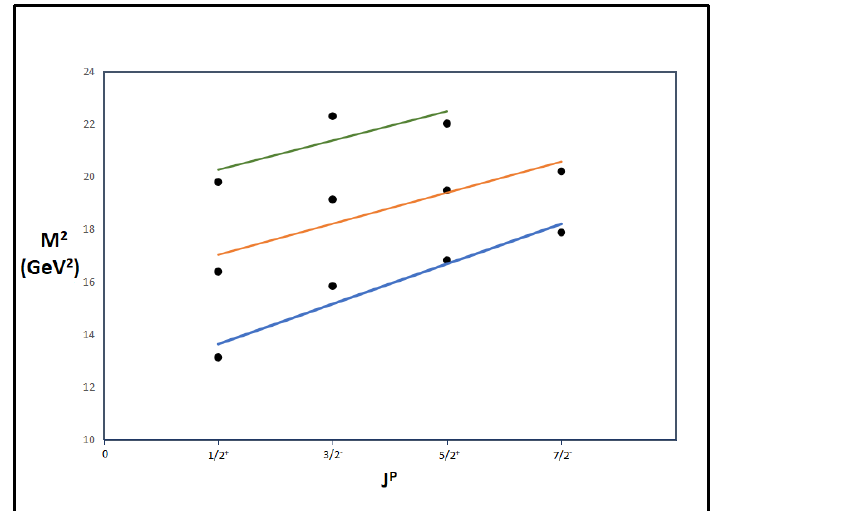
Figure 2. The regge trajectory of Ξ ++ cc baryon in (J, M 2 )